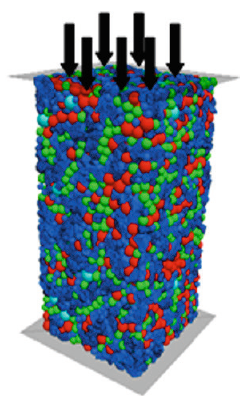
Figure 8. DE model of creep test after